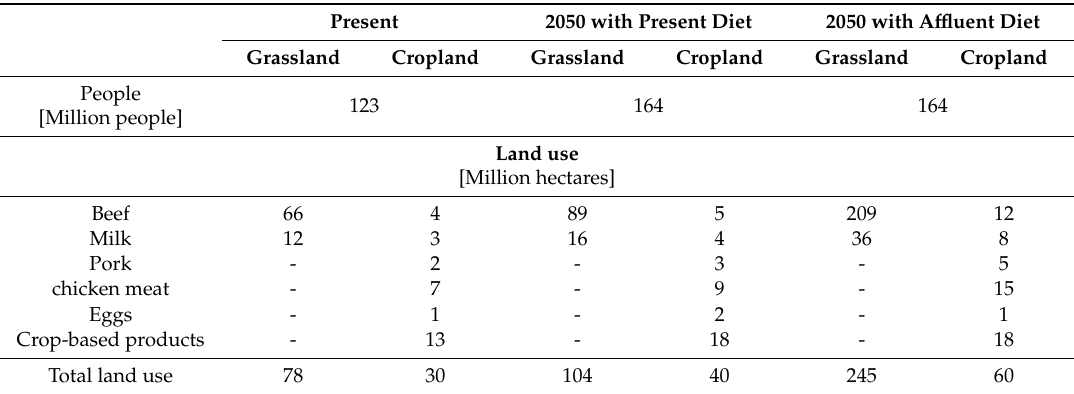
Table 7. Land use for the food consumption in Mexico. The first row shows the total population of Mexico. The rest of the rows show the values of Land use for food consumption for the total population of the country. See text for